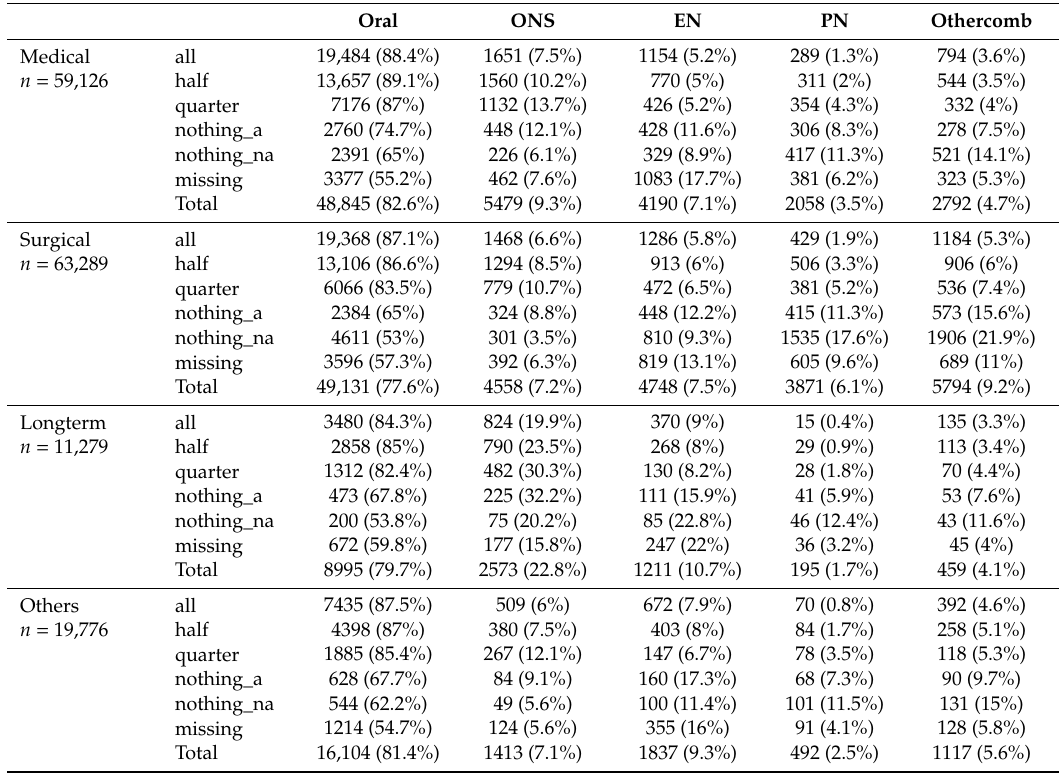
Table 3. Nutrition care versus amount eaten on nutritionDay according to the patients in the four studied groups.